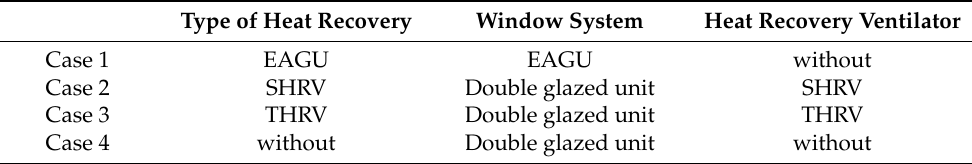
Table 1. Different types of exhaust air heat recovery units to be compared. Type of Heat